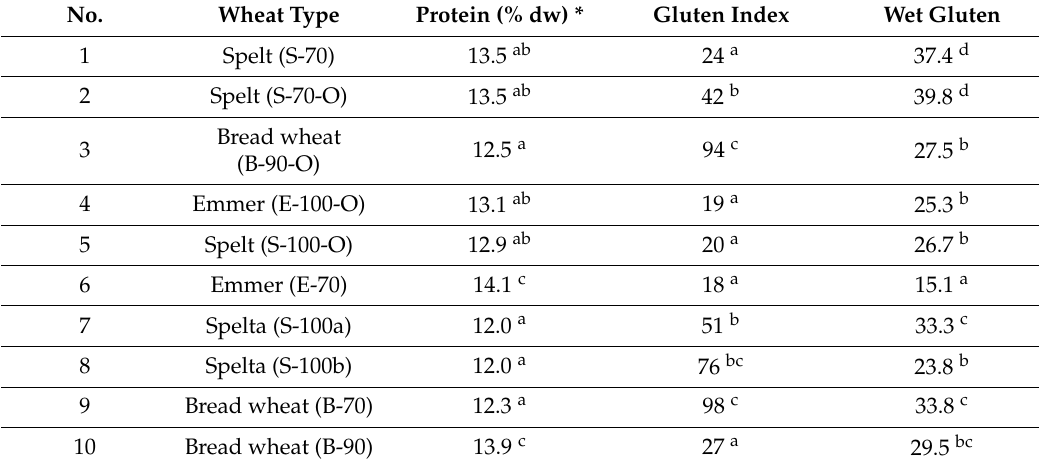
Table 4. Protein content of the tested